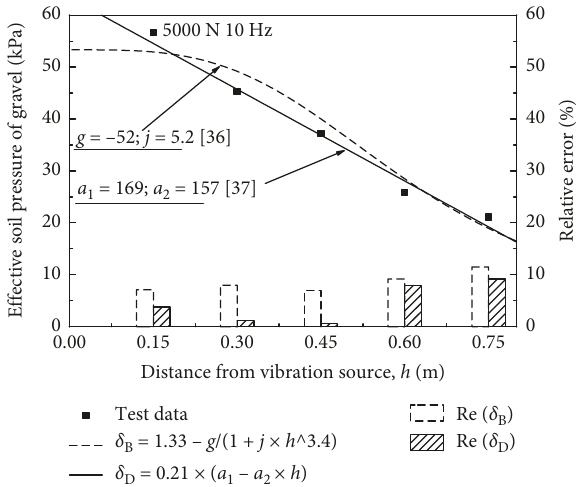
Figure 16: Test results and empirical formulae at different mea- surement points in the case of a single jack